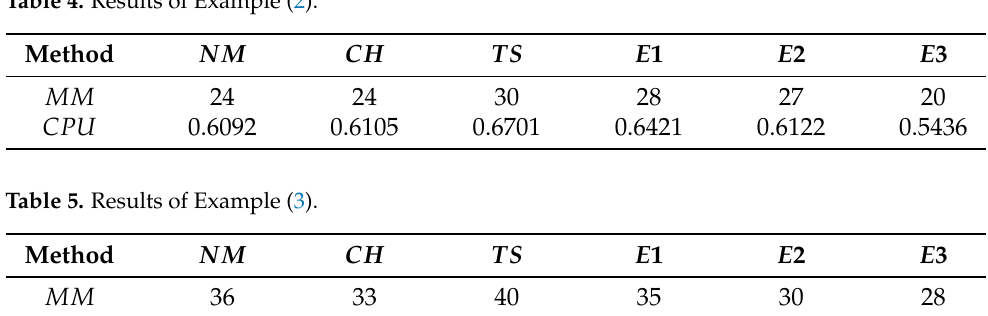
Table 4. Results of Example (2).